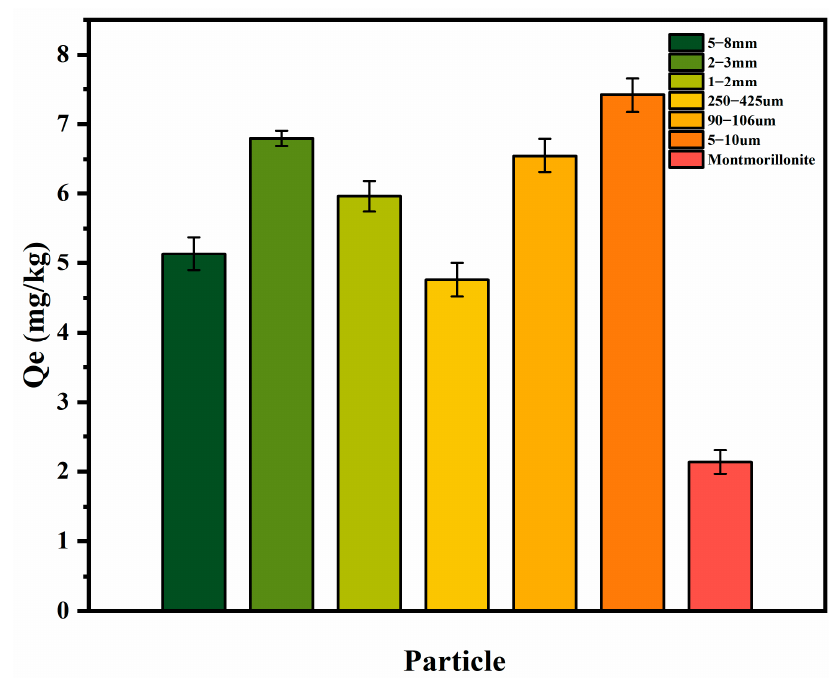
Figure 7. Adsorption capacity of di ff erent sediments towards SDZ at Re = 7500.